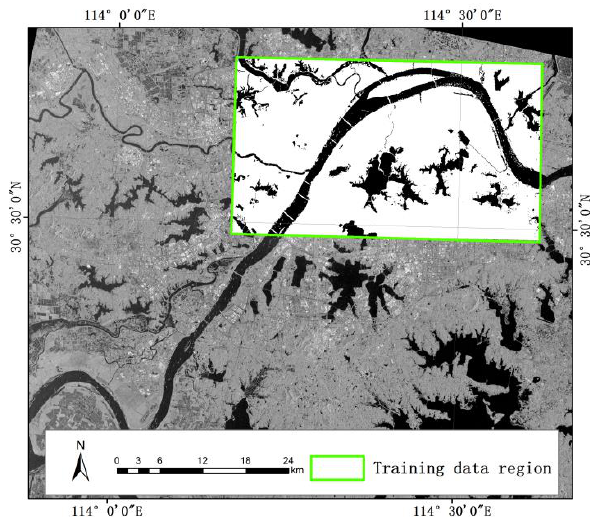
Figure 3. Training data region and label image